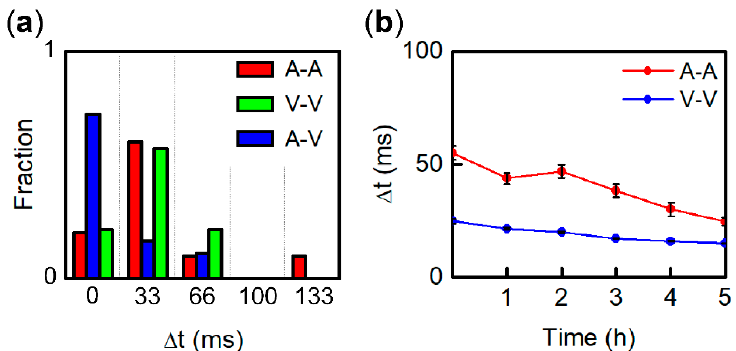
Figure 4. ( a ) Histogram of entrainment time at 1:1 synchronization. ( b ) Entrainment time transition measured by multi-electrode array (MEA) after 1:1 synchronization for A-A and V-V.